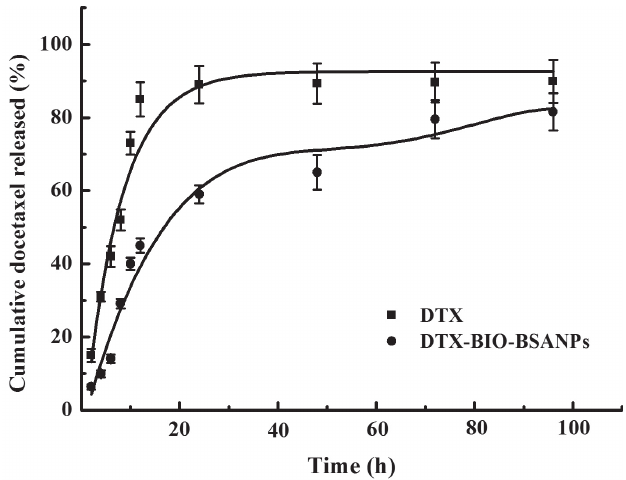
FIGURE 4 - In vitro docetaxel release profile from DTX-BIO- BSA-NPs and docetaxel (Taxoere TM ). Phosphate-buffered saline (0.1 M, pH=7.4) was selected as the release medium. The nanoparticle dispersion was put in an orbital shaker and shaken at 120 rpm at 37 ºC. High-performance liquid chromatography was performed to measure the released drug